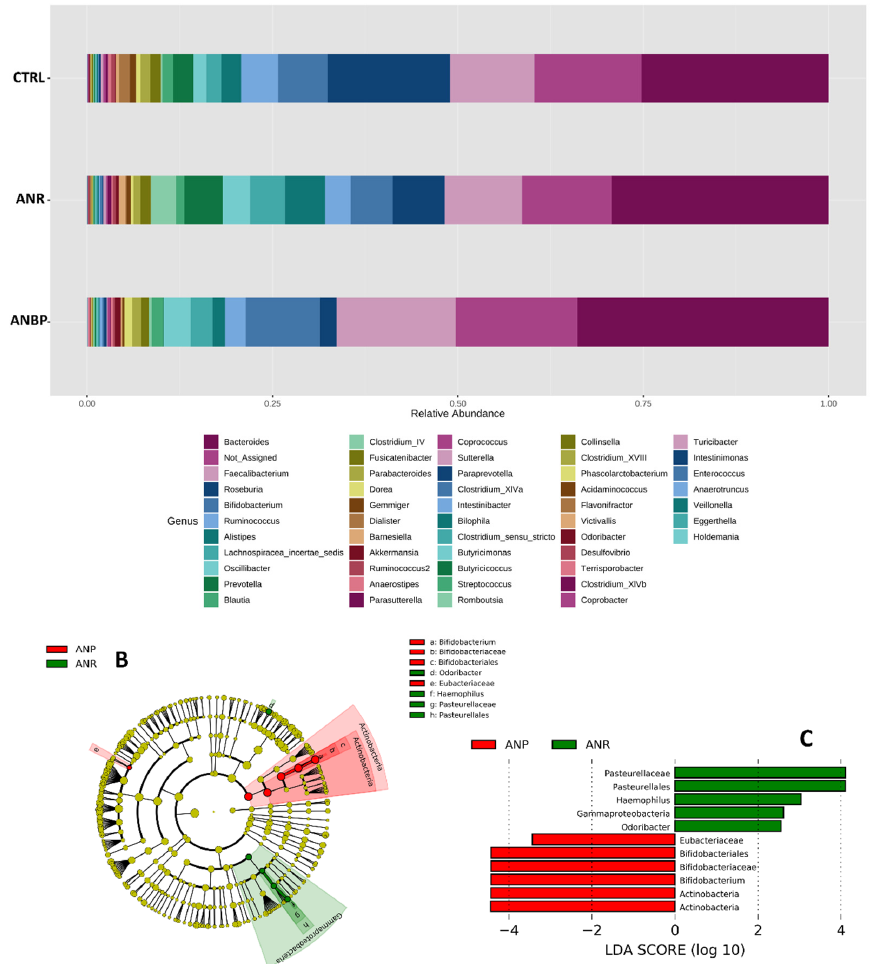
Figure 4. ( A ) Bacteria abundances in terms of genus in healthy subjects (CTRL), restricting (ANR) and binge-purging (ANP) anorexia nervosa patients during the acutely ill phase. ( B ) Cladograms generated by linear discriminant effect size (LEfSe) indicating differences in the bacterial taxa between ANR and ANP patients. Nodes in red indicate taxa that were enriched in ANBP, while nodes in green indicate the opposite trend. ( C ) Linear Discriminant Analysis (LDA) scores for the bacterial taxa differentially abundant between the two groups. Only taxa having a p < 0.01 were shown.